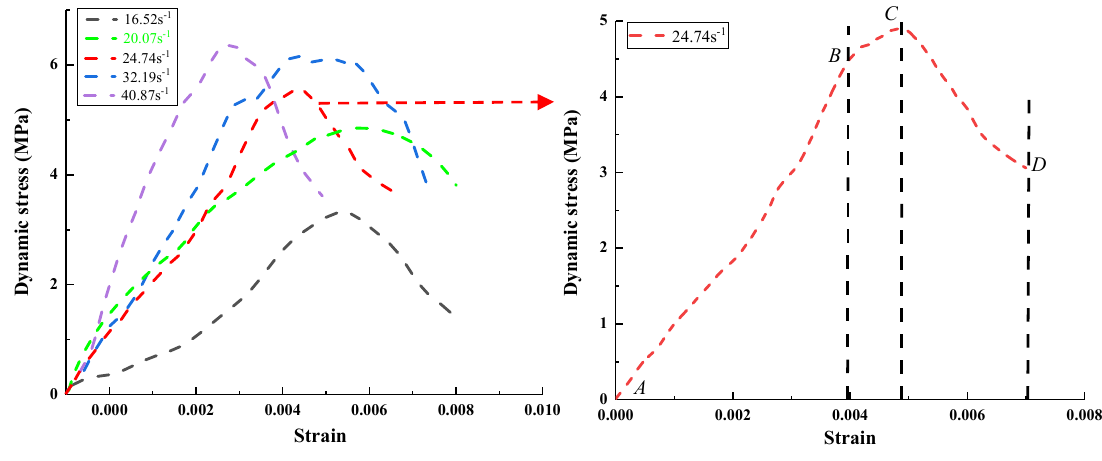
Fig. 7. Dynamic stress - strain curve of layered filling body 195 Figure 7. Dynamic stress − strain curve of layered filling body.